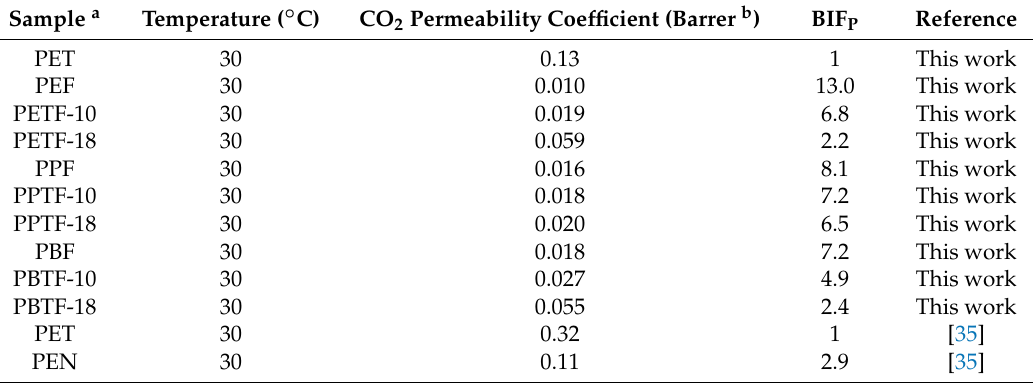
Table 5. CO 2 barrier properties of PEF, PPF, PBF, and the copolyesters modified with CBDO. Sample